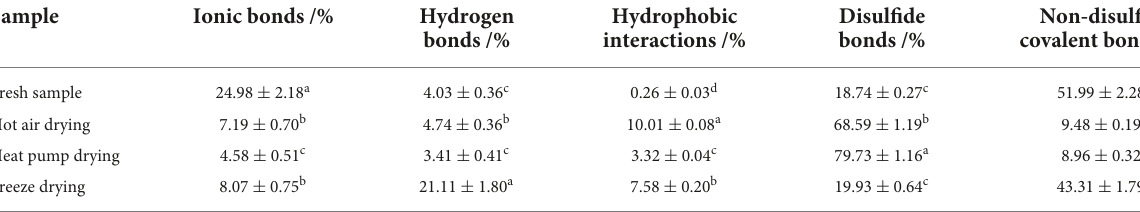
TABLE 1 Effect of different drying methods on chemical forces in myofibrillar protein.